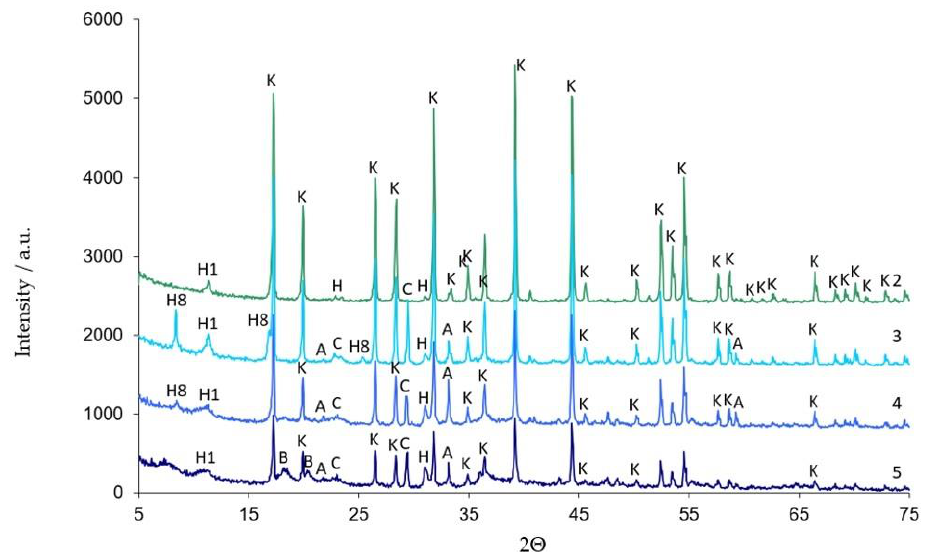
Figure 8. Diffractograms of the tested C 3 A samples: 2 — C 3 A kept in water (W), 3 — sample from pig slurry (G), 4 — corn silage (K) and 5 — chicken manure (5); A — C 3 A, C — CaCO 3 ; H 1 — Ca 2 Al(OH) 7 ·3H 2 O; H 8 — Ca 2 Al 2 O 5 ·8H 2 O; K — C 3 Al 2 (OH) 12 ; B — Al(OH) 3.